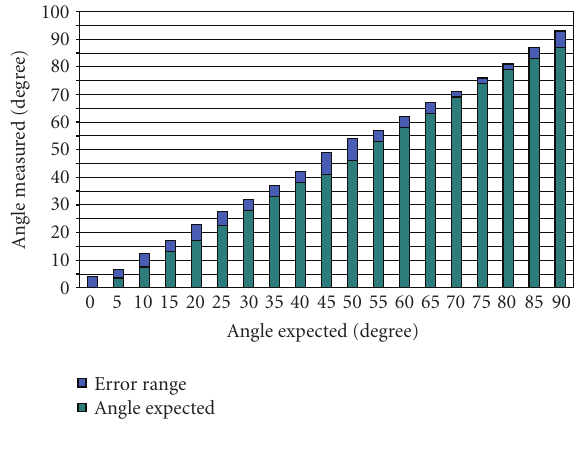
Figure 9: Accuracy as a function of the angle.